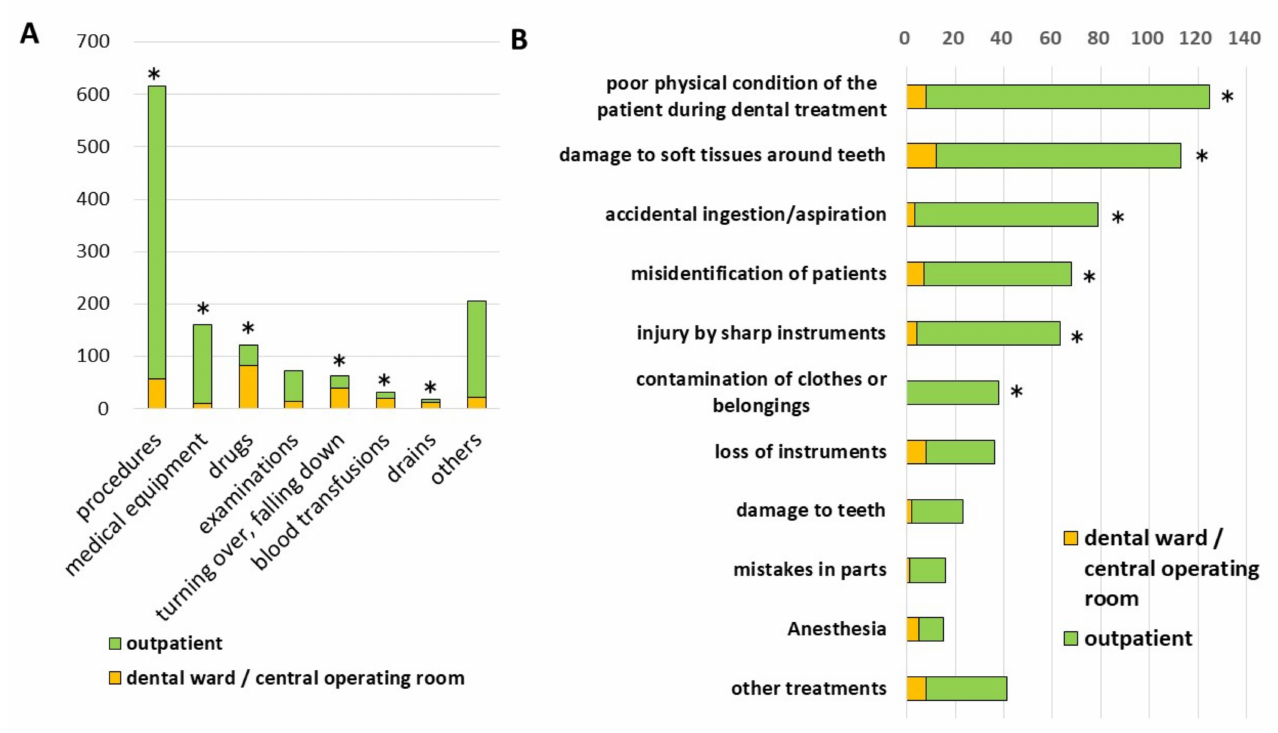
Figure 2. ( A ) The number of incident reports from different location. (* p < 0.05) ( B ) The classification of the incident reports related to the procedure from different